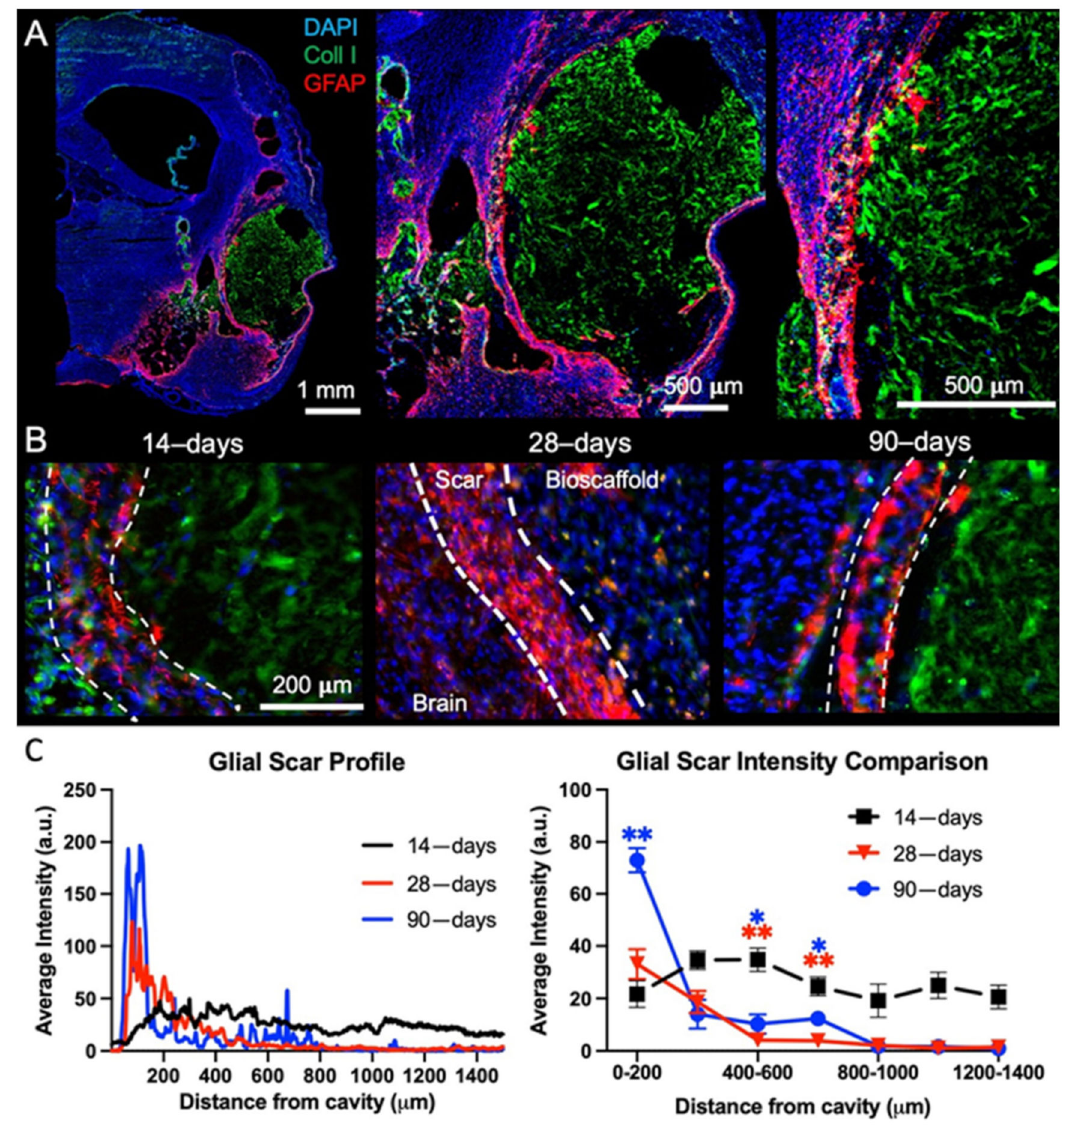
Figure 3. Glial scarring and tissue astrocytosis. ( A ) To assess the impact of ECM hydrogel implantation timing on glial scarring, whole hemisphere images encompassing the lesion cavity were acquired to measure the level of astrocytic (GFAP) reactivity at each time point. A 90-days post-stroke implantation brain is shown here. ( B ) It is important to note the morphological difference in astrocytic activity at different time points, with the 14-days post-stroke implantation exhibiting more diffuse scarring, whereas 90-days post-stroke, the glial scar has become more compact. In the case of the 28-days post-stroke implantation, the ECM hydrogel adjacent to the glial scar was degraded and replaced with de novo tissue, as evidenced here by the almost complete absence of collagen I staining on the lesion cavity/bioscaffold side. ( C ) A quantitative analysis of the scar profile confirms an intensity increase in GFAP from the 14- to 90-days post-stroke at the edge of the lesion. In contrast, a decrease of astrocytosis away from the cavity border was evident at 90-days compared to 14-days post-stroke. (* p < 0.01, ** p <